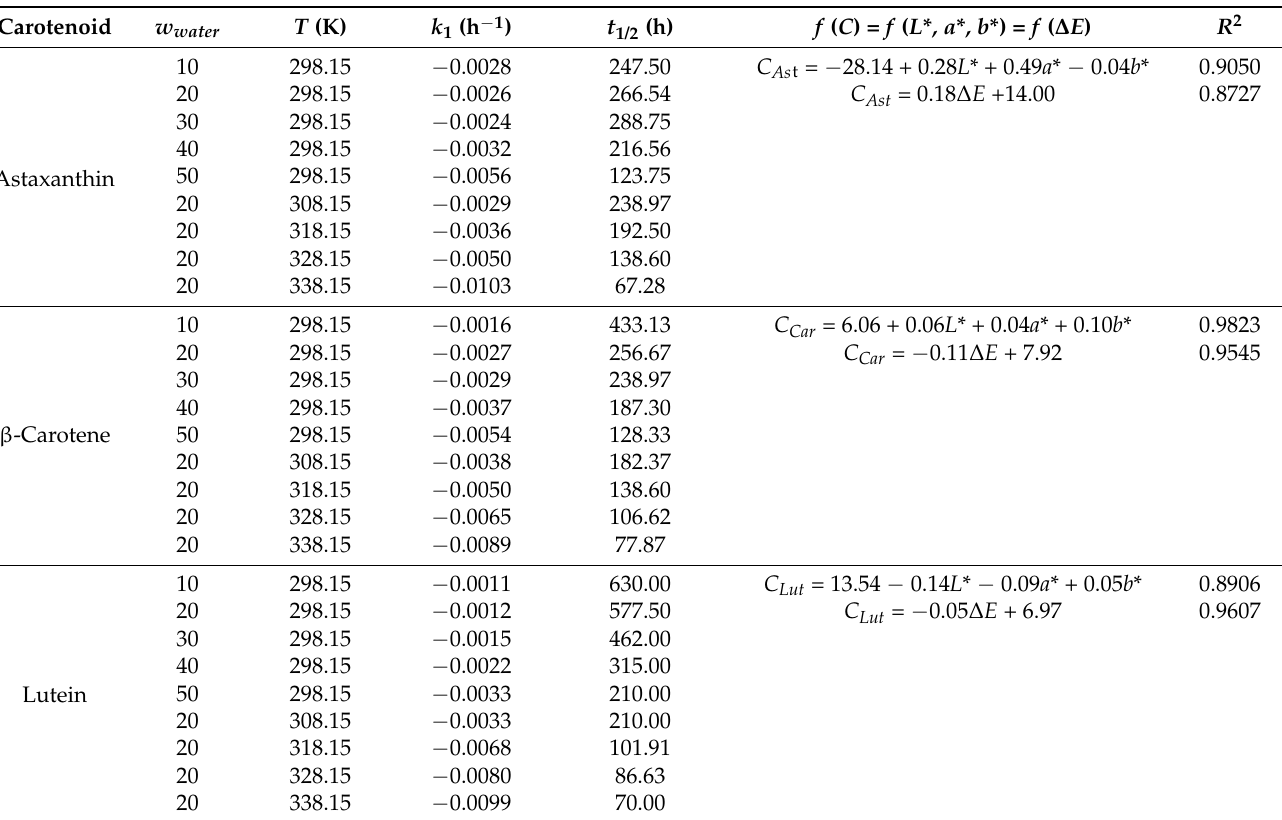
Table 3. The rate constants ( k 1 , h − 1 ), t 1/2(h) and the relationship between the concentration of carotenoids and chromatic